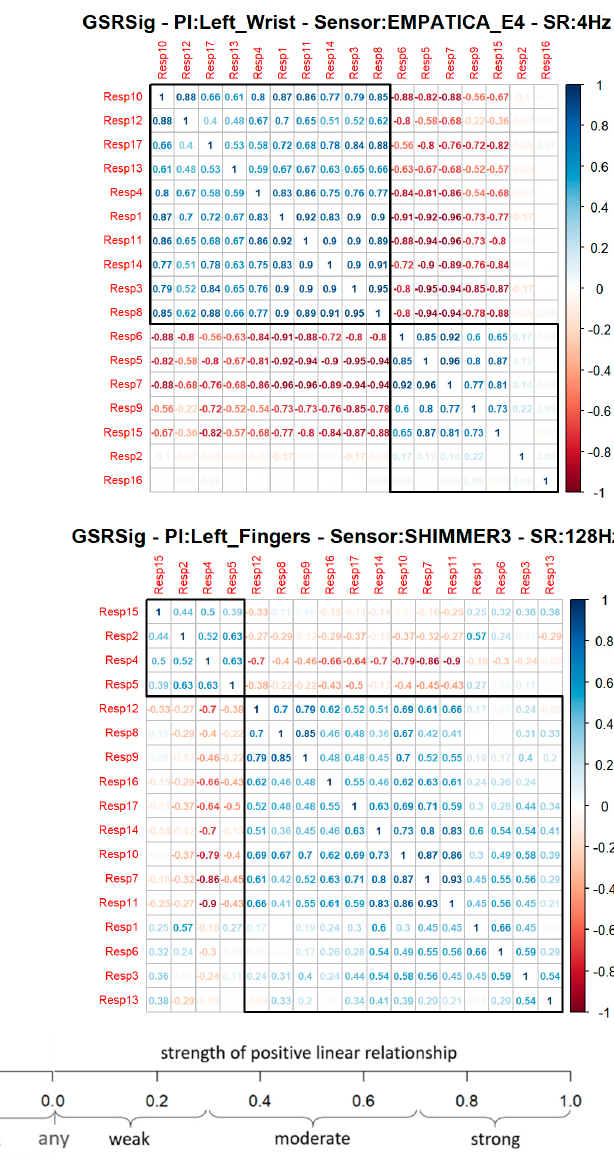
Figure 4. Correlation matrix of each GSR measurement location.